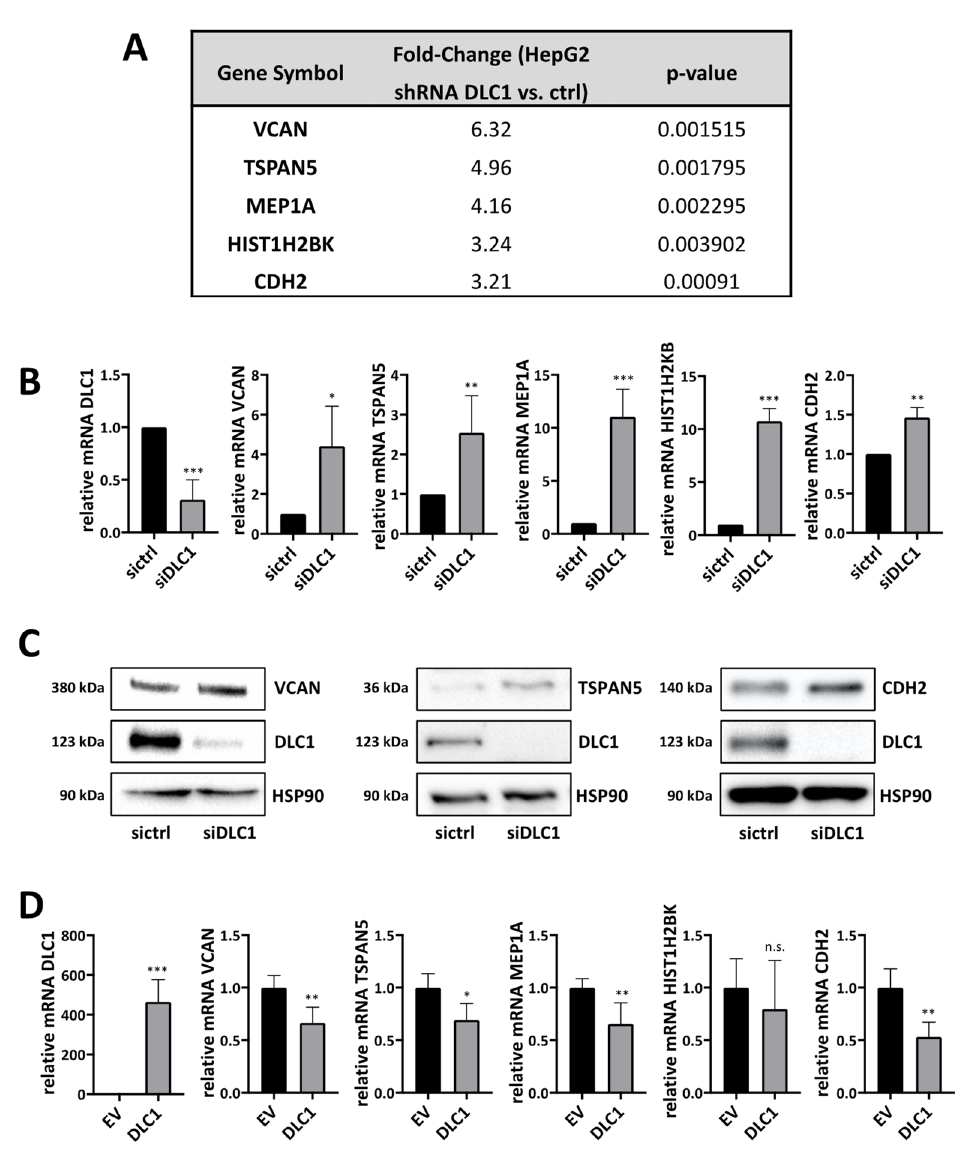
Figure 1. Gene expression profiling to identify novel target genes induced by DLC1 loss. ( A ) DNA microarray analysis was performed to analyze the transcriptome of HepG2 cells either expressing control shRNA (ctrl) or DLC1 shRNA. Genes are ordered to the average fold of upregulation upon DLC1 depletion and the corresponding p-values are given. The threshold for DLC1 dependence was set at 3.2-fold upregulation. ( B ) Expression levels of the indicated target genes in HepG2